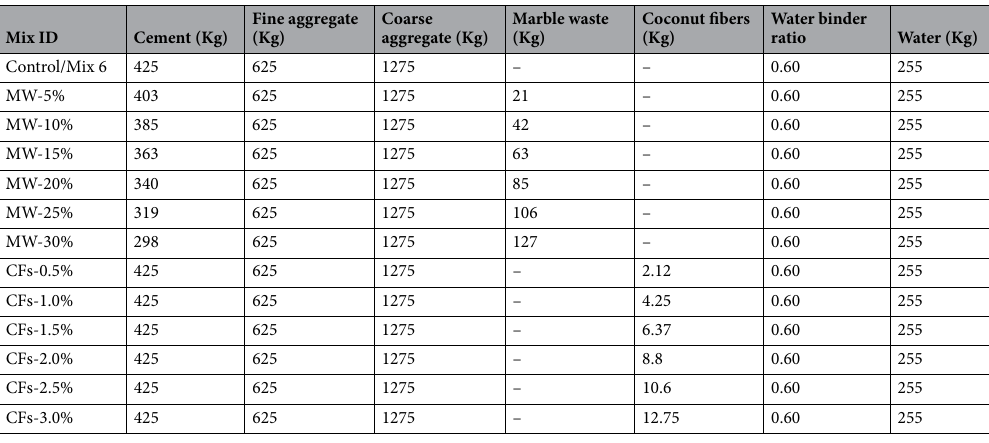
Table 9. Mix proportion of materials per m 3